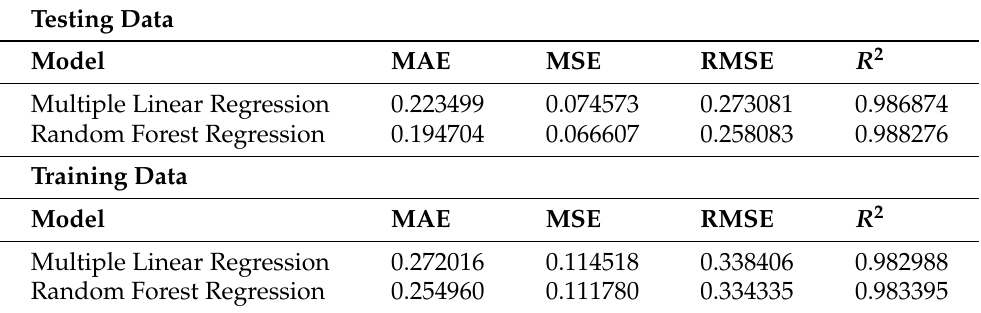
Table 5. Fitting accuracy of the